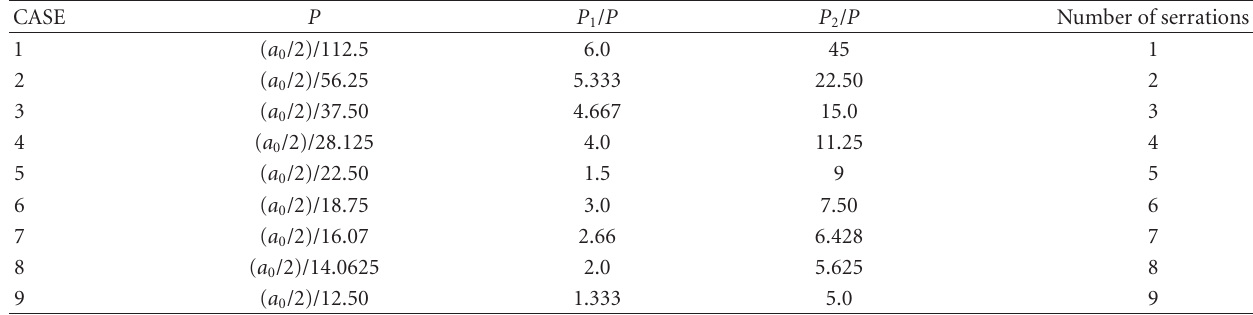
Table 2: Width modulation factors for NISE serrations.